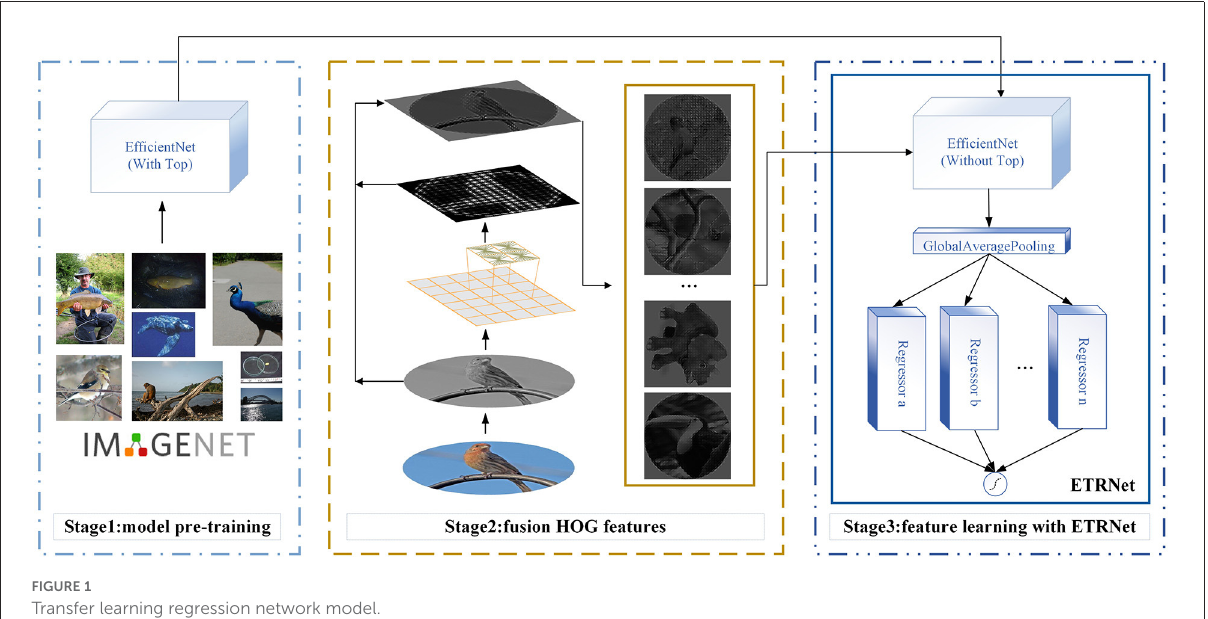
FIGURE1 Transfer learning regression network